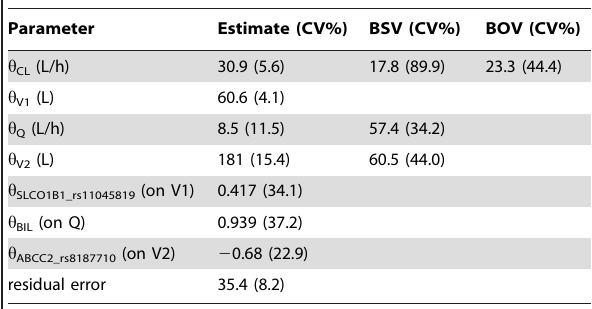
Table 7. Final model parameter